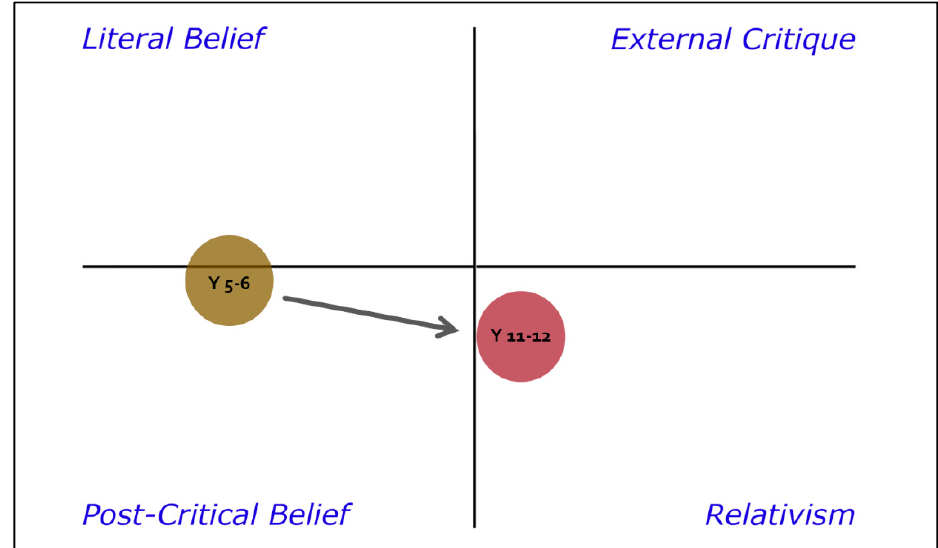
Figure 3. Evolution of students as they transition from primary to secondary education.